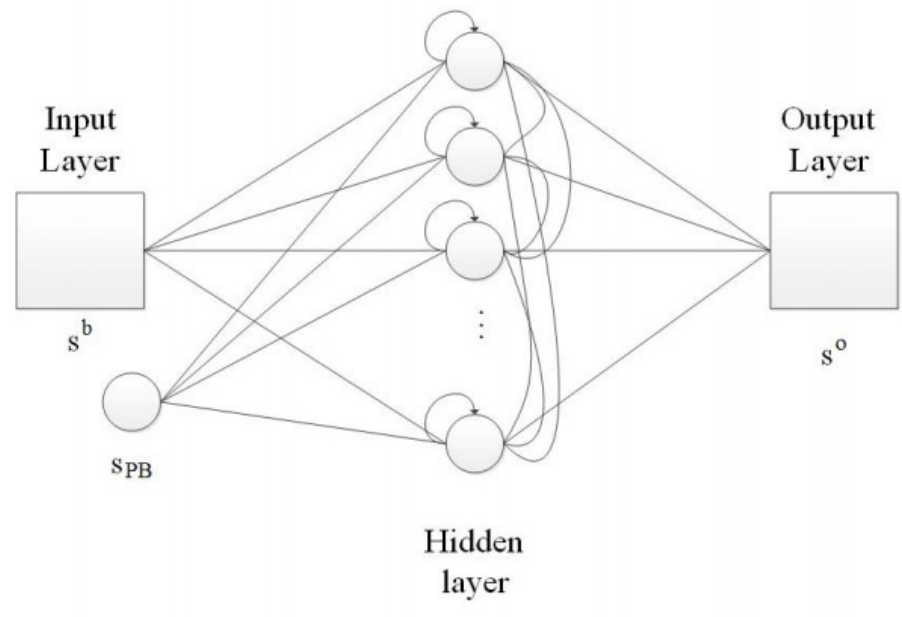
Figure 6. An emotion recognition deep-learning based on Kinect